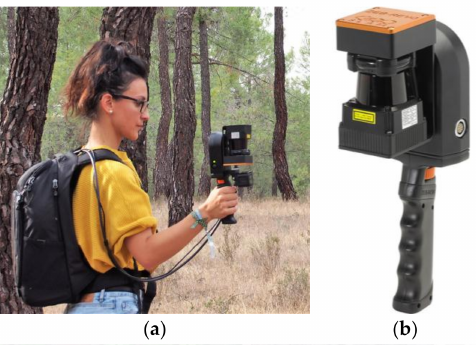
Figure 1. GeoSLAM ZEB-REVO device: ( a ) Complete backpack system and ( b ) detail of the rotating head. Table 1. Technical specifications of the GeoSLAM ZEB-REVO device.